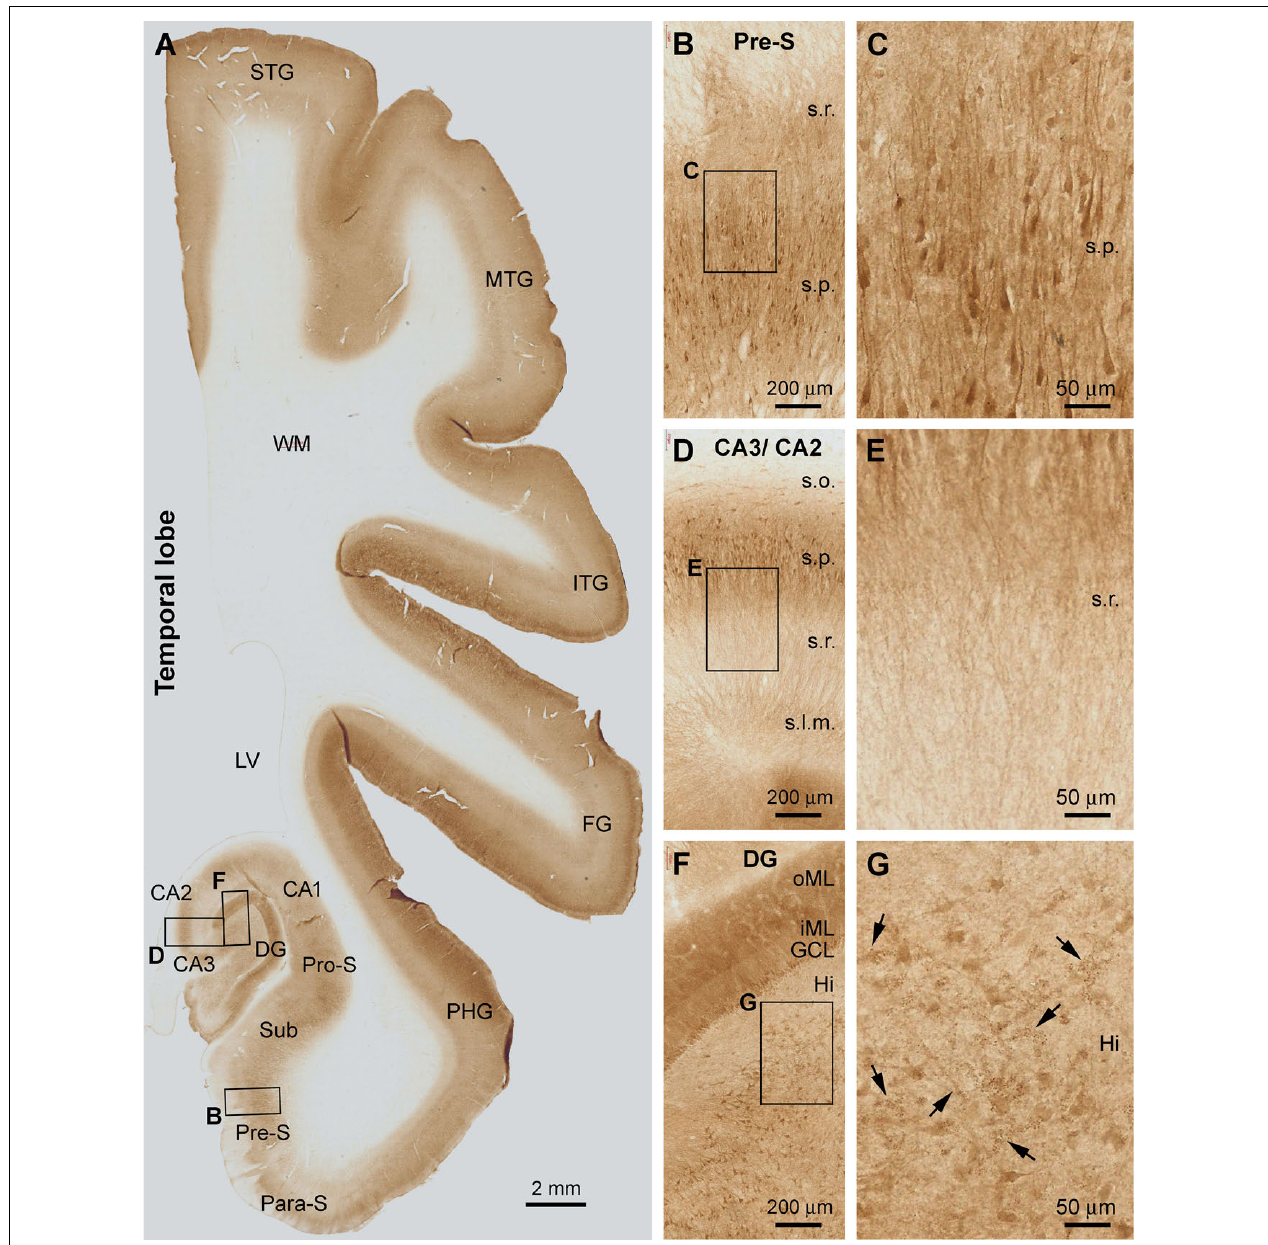
FIGURE 3 | Shank3 IR in the temporal neocortex, entorhinal cortex, and hippocampal formation. The pattern seen in the neocortex and transitional entorhinal cortex is comparable to that in the frontal associative neocortex shown in Figure 1 . In the subicular subregions (A–C) and the Ammon’s horn CA1-3 sectors (A,D,E) , Shank3 IR is present in the neuropil as well as the somata and dendritic processes of the pyramidal neurons over the stratum radiatum (s.r.) and stratum pyramidale (s.p.). The distal parts of apical dendritic processes extend into the stratum lacunosum-moleculare (s.l.m.), whereas little labeling is seen in the stratum oriens (s.o.) (D, E). In the dentate gyrus (DG), the molecular layer (ML) and the granule cell layer (GCL) are strongly labeled. The inner ML (iML) appears lighter than the outer ML (oML) (F) . In the hilus (Hi), mossy cells and their dendrites are moderately labeled, as are some cluster profiles likely representing the thorny excrescences ( G , pointed by arrows). STG, superior temporal gyrus; MTG, middle temporal gyrus; ITG, inferior temporal gyrus; FG, fusiform gyrus; PHG, parahippocampal gyrus; Para-S, parasubiculum; Pre-S, subiculum; Sub, subiculum; Pro-S, prosubiculum; LV, lateral ventricle; WM, white matter. Scale bars are as